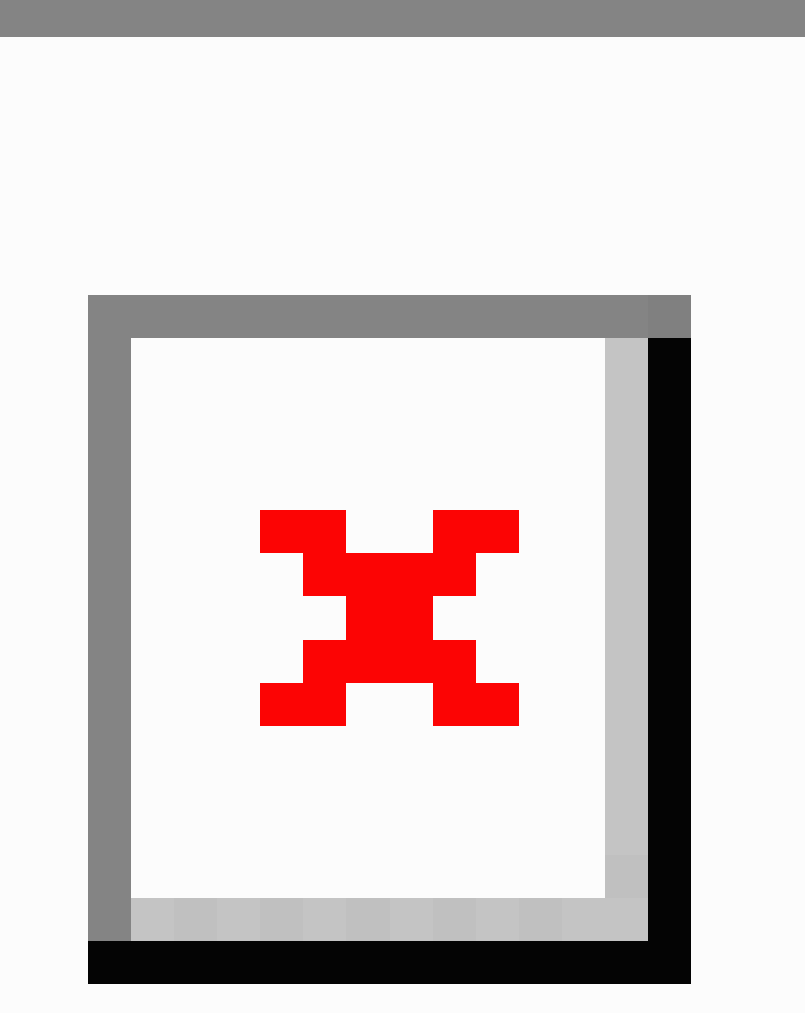
Figure 3. Feature importance for emotional transition detection of the general model obtained using XGBoost and shapley additive explanation. The figure represents the contribution of the corresponding feature to detect whether there is a